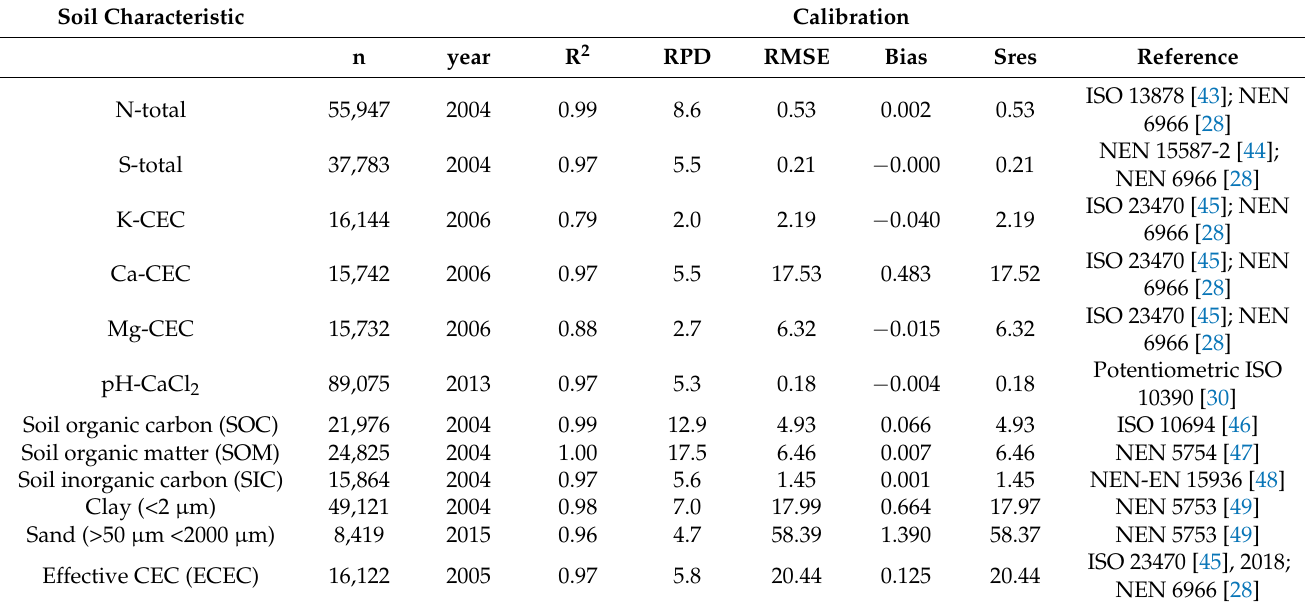
Table 2. Soil characteristics, number of samples (n), year of introduction into routine soil testing, determination coefficient (R 2 ), RPD, root mean squared error (RMSE), average difference between NIRS and reference (bias), standard deviation of residuals (Sres), and references of the reference methods for the calibration data set.